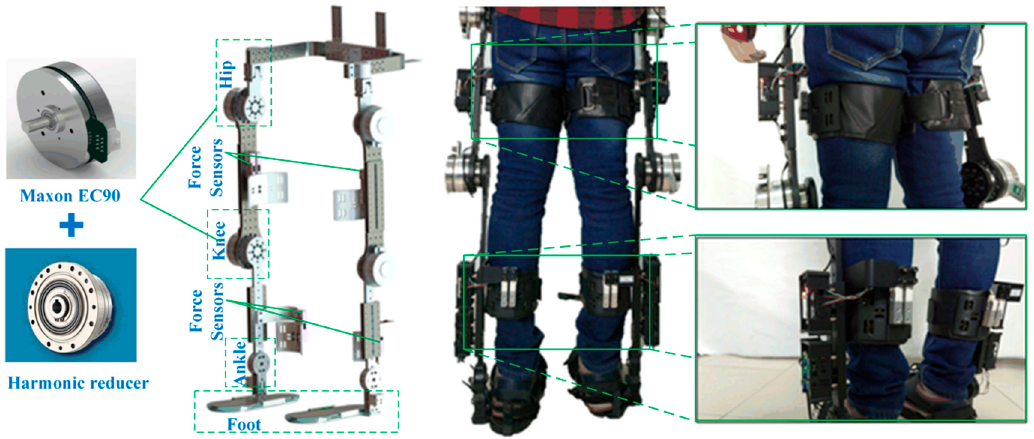
Figure 1. Main structure of LLRE and schematic diagram of the connection between the wearer and the exoskeleton. the